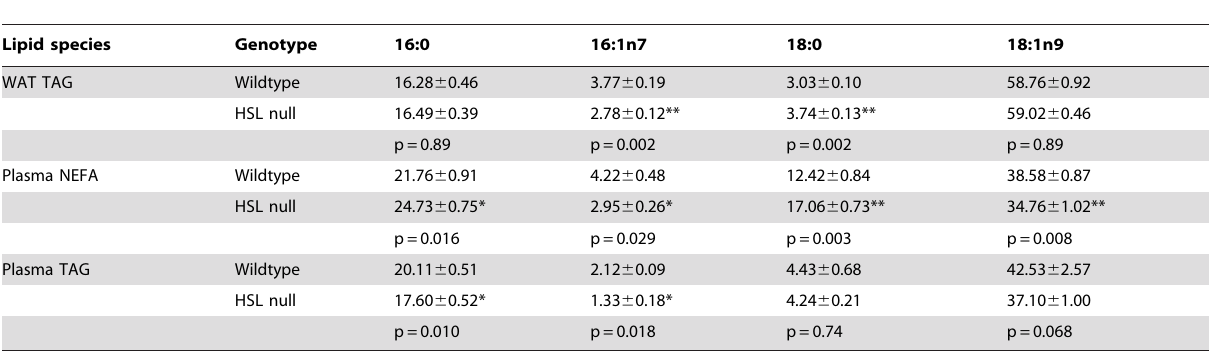
Table 2. Fatty acid profile in WAT and plasma of wildtype and HSL null mice.